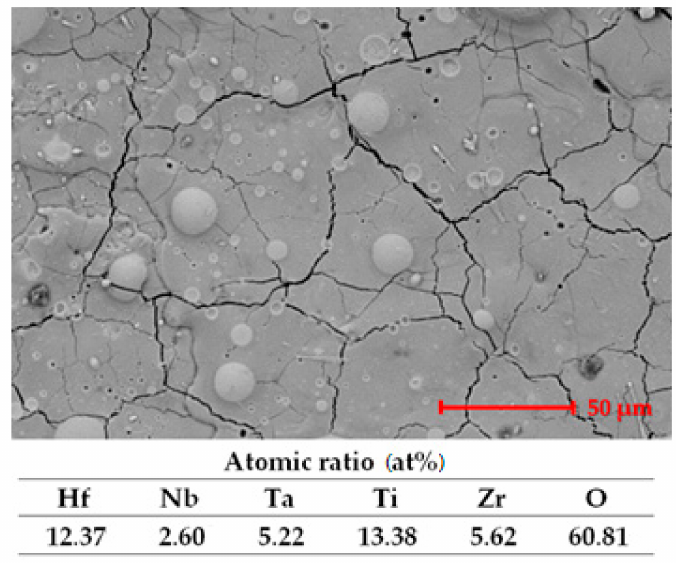
Figure 6. SEM image and EDS analysis results after exposure to